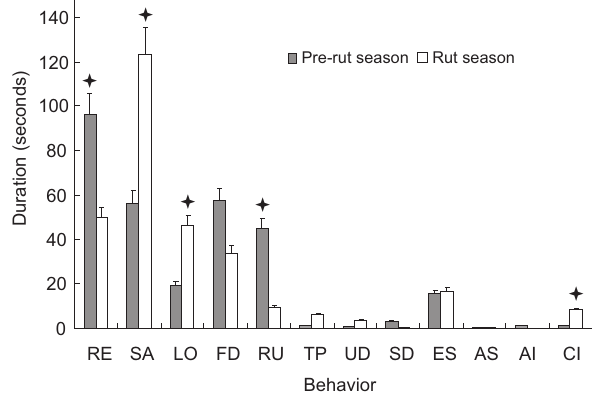
Figure 1. Average duration of male musk deer behavior patterns during the rut and pre-rut seasons. ( RE) Resting, (SA) standing- alert, (LO) locomotion, (FD) feeding/drinking, (RU) ruminating, (TP) tail pasting, (UD) urinating/defecating, (SD) self-directed be- havior, (ES) environmental sniffing, (AS) anogenital sniffing, (AI) affinitive interaction, (CI) agonistic interaction, ( (cid:143) ) significant dif-